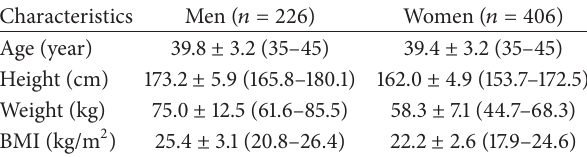
Table 1: Anthropometric characteristics and other variables in the men and women aged 35–45 yr used to calculate the reference intervals of the bone turnover